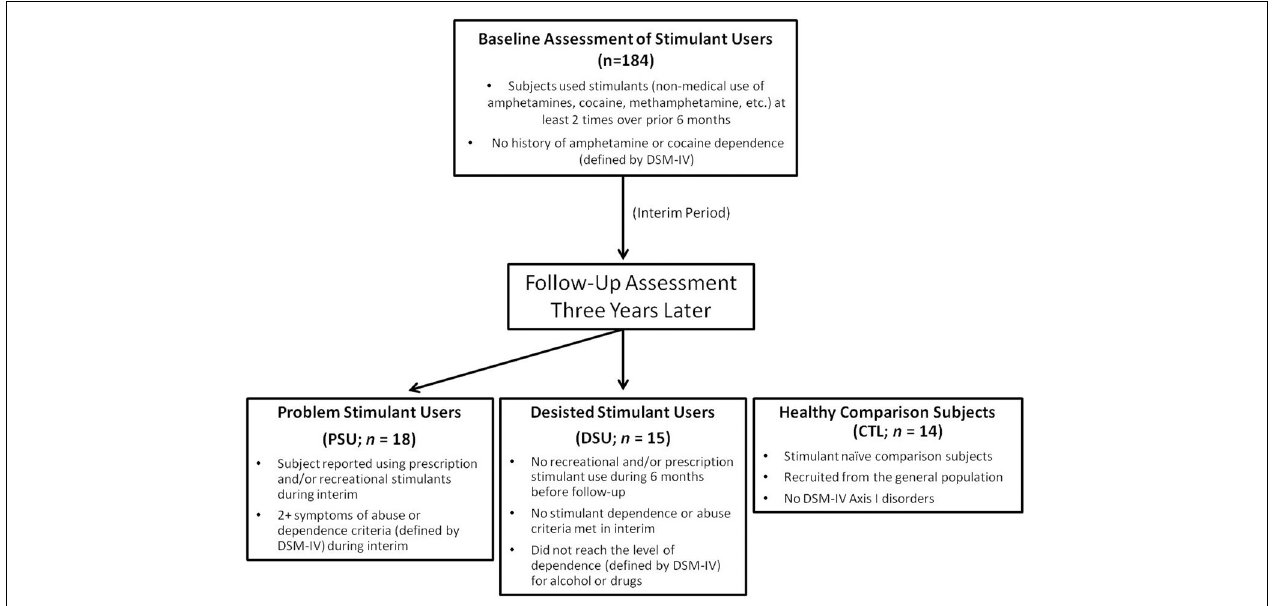
FIGURE 1 | Timeline of subject recruitment. Occasional stimulant users were followed up 3 years later to determine which individuals escalated stimulant use (Problem Stimulant Users; PSU) or desisted